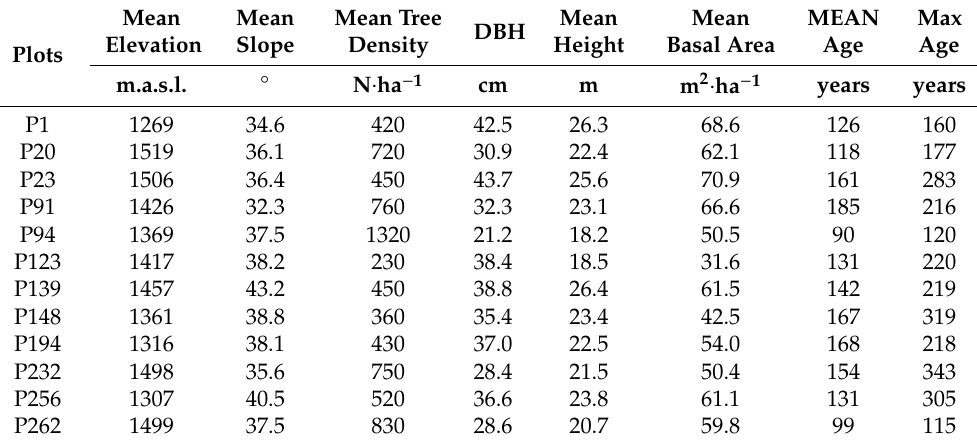
Table A1. Main Stand Characteristics of the Sampled Plots.